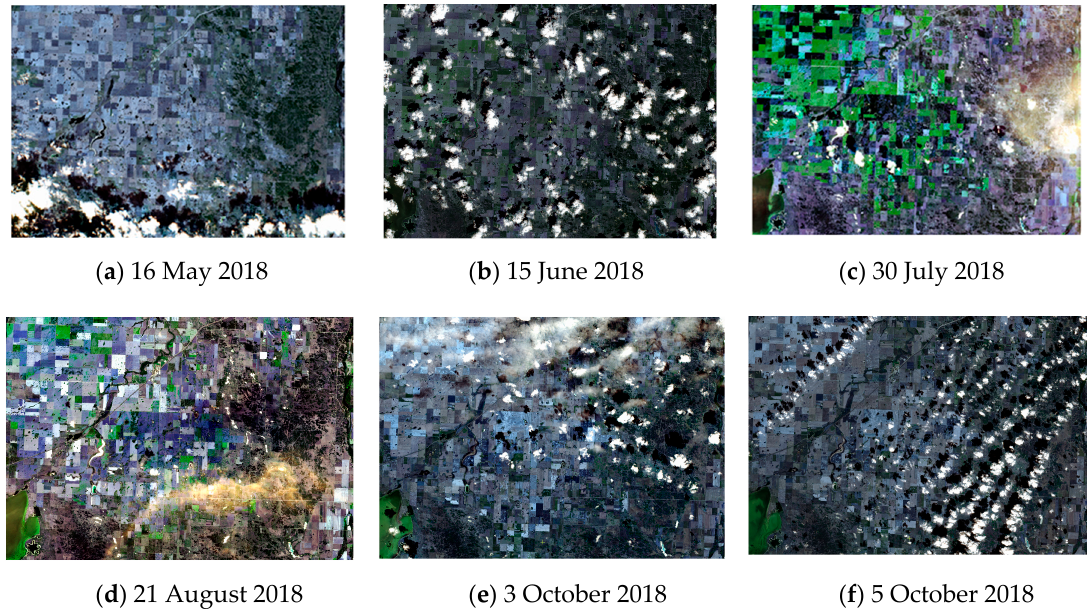
Figure 6. Sentinel-2 observations with cloud and haze contamination acquired on ( a ) 16 May, ( b ) 15 June, ( c ) 30 July, ( d ) 21 August, ( e ) 3 October, and ( f ) 5 October 2018.